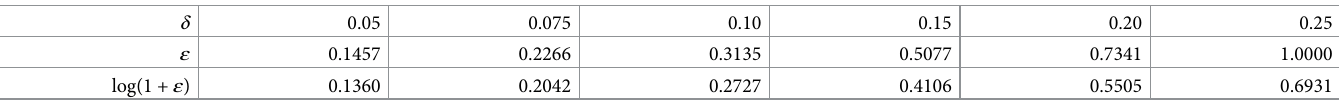
Table 1. Numerical correspondence between equivalence margins referring to || F − F 0 || and the Lehmann parameter θ .